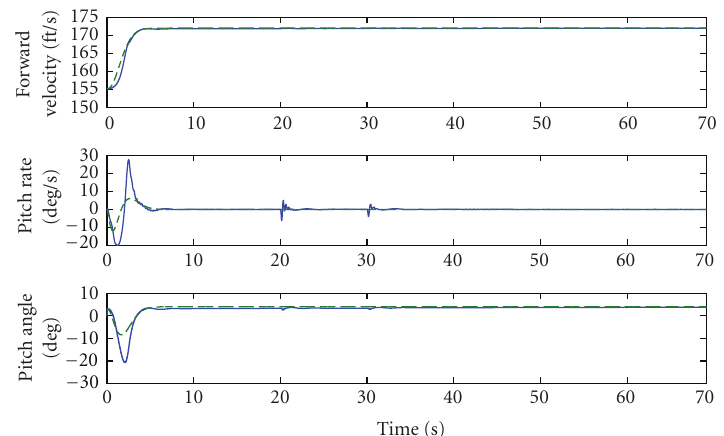
Figure 17: Time history of longitudinal states (solid) and reference model states (dashed).